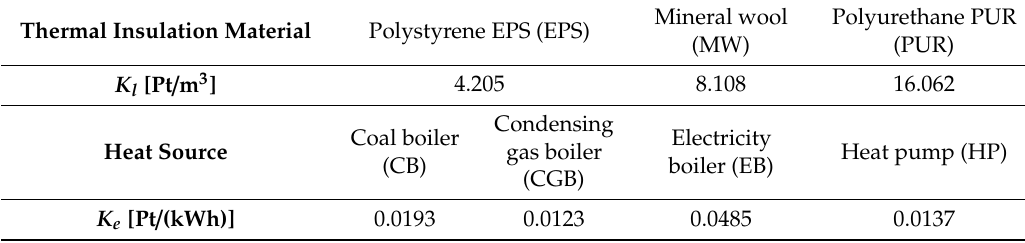
Table 3. The results of life-cycle assessment (LCA) analysis for thermal insulation materials and heat